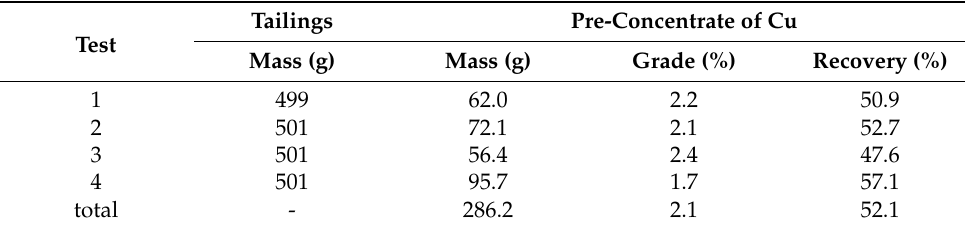
Table 7. Results of the performed flotation tests for copper oxides and sulfides. The tests were carried out with 0.5 kg sample material. As not all the non-magnetic material was used to carry out the tests, the recovered mass (Figure 7 and Table 6) in the Cu pre-concentrates was extrapolated. Tailings Pre-Concentrate of Cu Test Mass (g) Mass